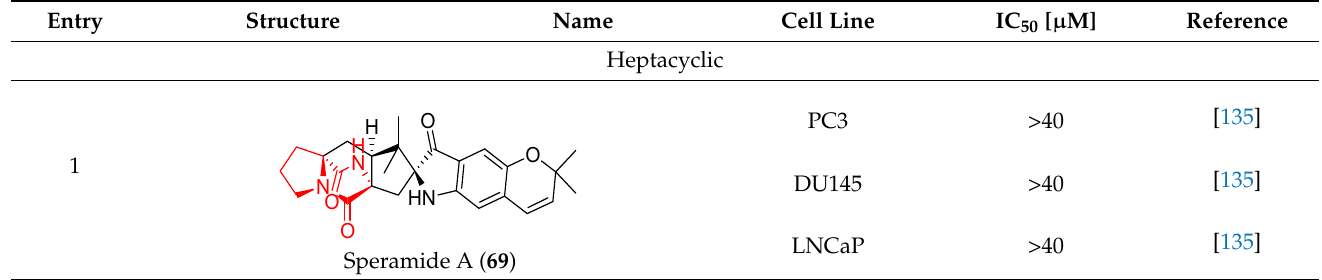
Table 5. Hepta-, polycyclic and dimeric proline-based DKP. Table 5. Hepta ‐ , polycyclic and dimeric proline ‐ based